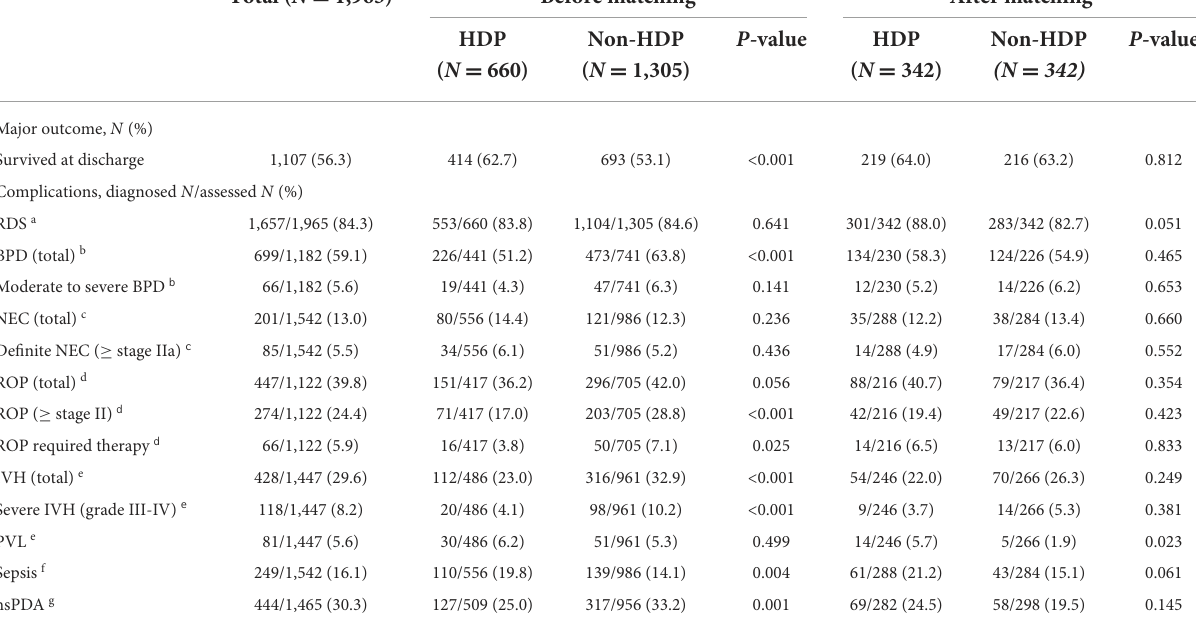
TABLE 3 The clinical outcomes of EP/ELBW infants in HDP and non-HDP groups. Total ( N = 1,965) Before matching After matching HDP ( N = 660)